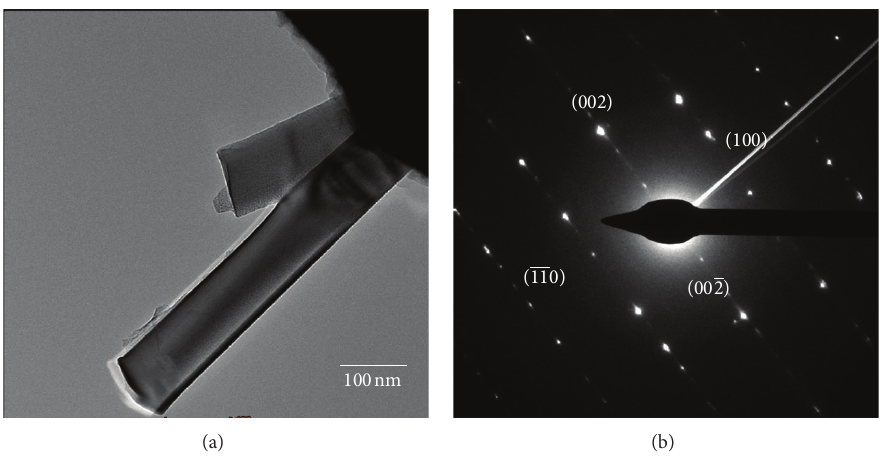
Figure 7: (a) TEM image and (b) SAED image of ZnO NRs grown on the stainless steel